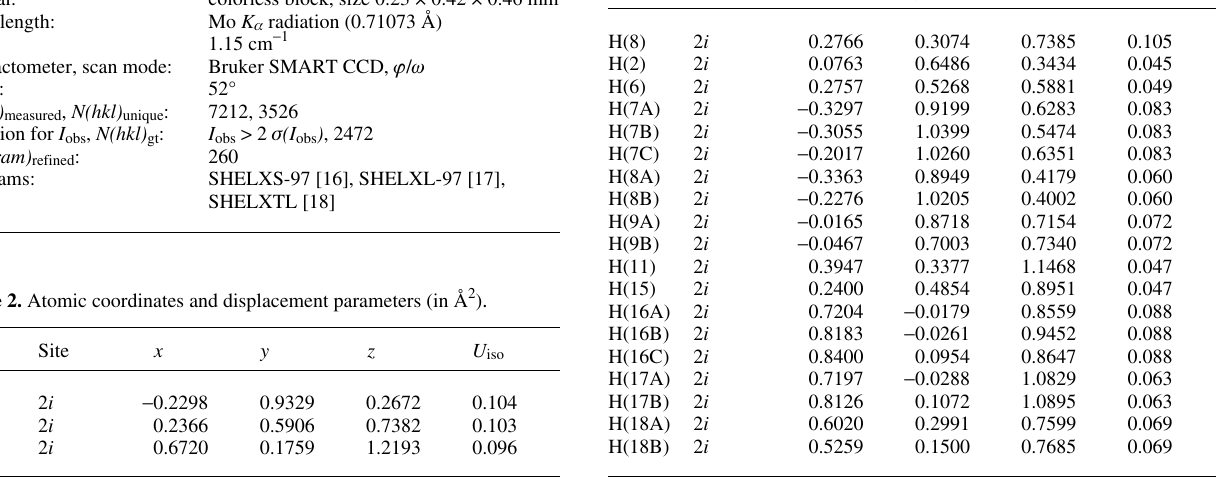
Table 3. Atomic coordinates and displacement parameters (in Å 2 ) .